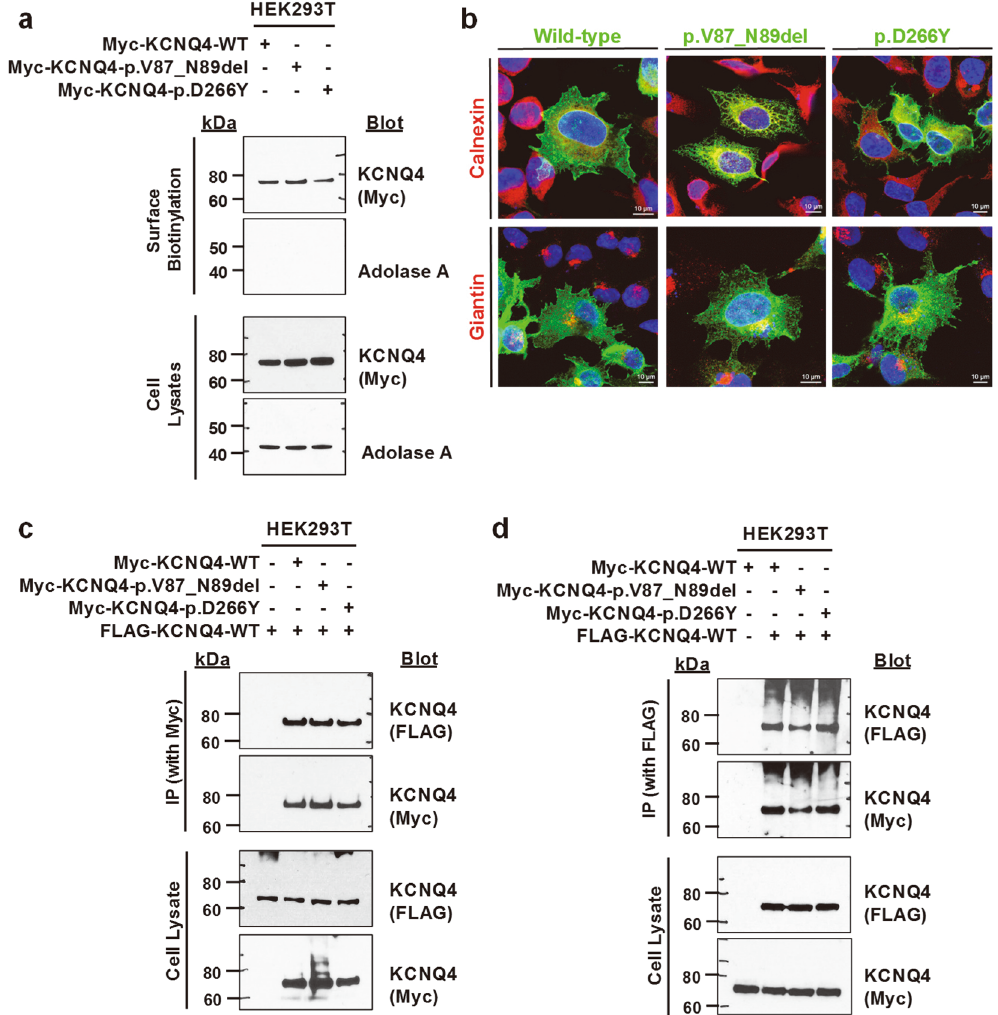
Figure 2. Surface expression and subunit interactions of WT and mutant KCNQ4 proteins. HEK293T or HeLa cells were transfected with N-terminally Myc- or Flag-tagged WT and mutant KCNQ4 clones. ( a ) Cell surface biotinylation in HEK293T. Proteins on the plasma membrane were labelled with biotin, isolated with avidin beads, and assessed by western blotting. Surface expression of two mutant KCNQ4 proteins was similar to that of WT protein. ( b ) Immunofluorescence of WT and mutant KCNQ4 proteins in HeLa cells. Cells were immunostained with anti-Myc, anti-calnexin, and anti-giantin antibodies. Nuclei were stained with DAPI. Calnexin and giantin are markers for the endoplasmic reticulum and Golgi apparatus, respectively. Both mutant KCNQ4 proteins and WT protein were observed on the plasma membrane. ( c–d ) Subunit interactions between WT and mutant KCNQ4 proteins. Twenty-four hours post-transfection, whole-cell lysates were subjected to immunoprecipitation using anti-Myc ( c ) or anti-FLAG ( d ) antibodies and immunoblotted. Both KCNQ4 mutant proteins interacted with WT